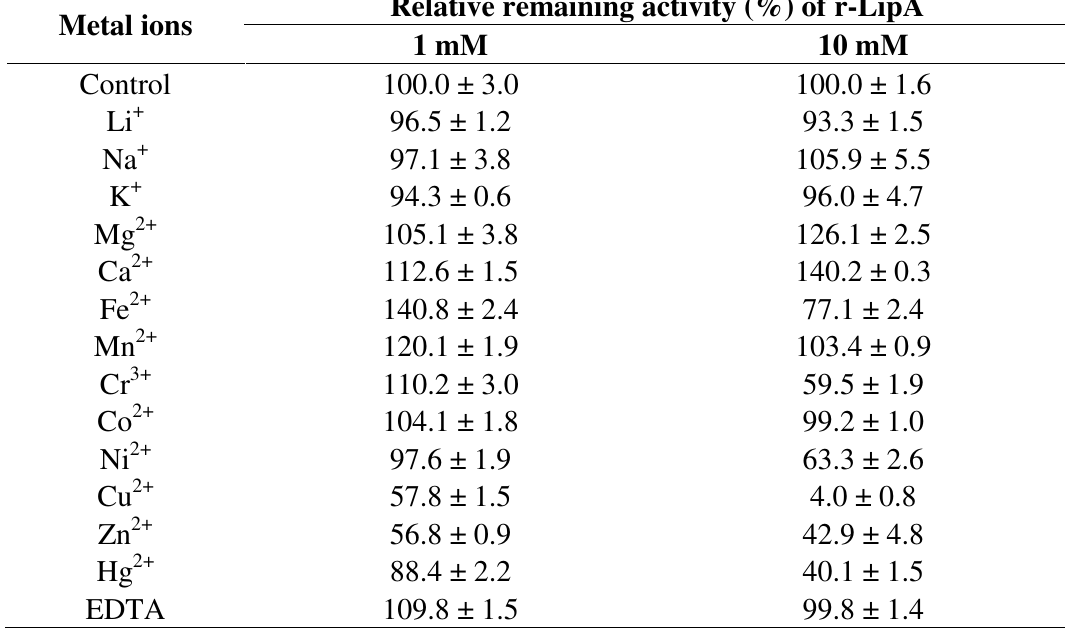
Table 1. Effects of various metal ions on the activity of r-LipA. The reactions contained various metal ions at a final concentration of 1 or 10 mM and then the lipase activity was measured under standard conditions (30 °C, 10 min). The activity of r-LipA determined in three independent experiments.